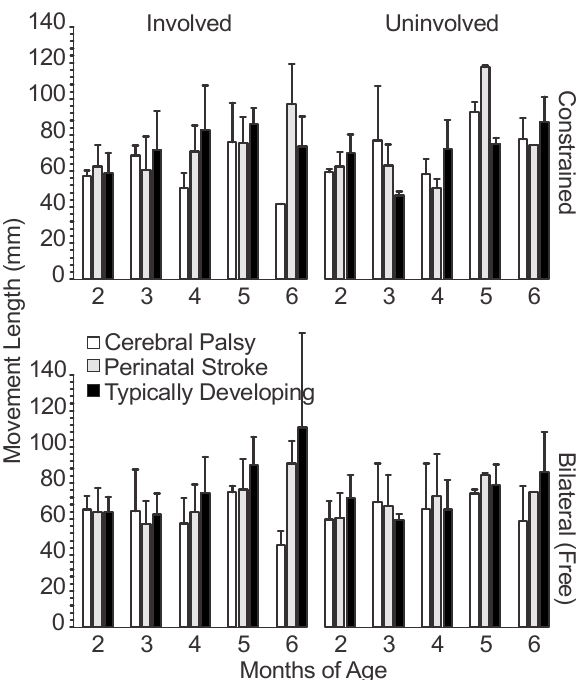
Figure 2. Mean movement length by age, side and condition. For typically developing infants, the left arm is plotted alongside the involved limb and the right arm is plotted alongside the uninvolved limb. Error bars show 1 standard deviation.